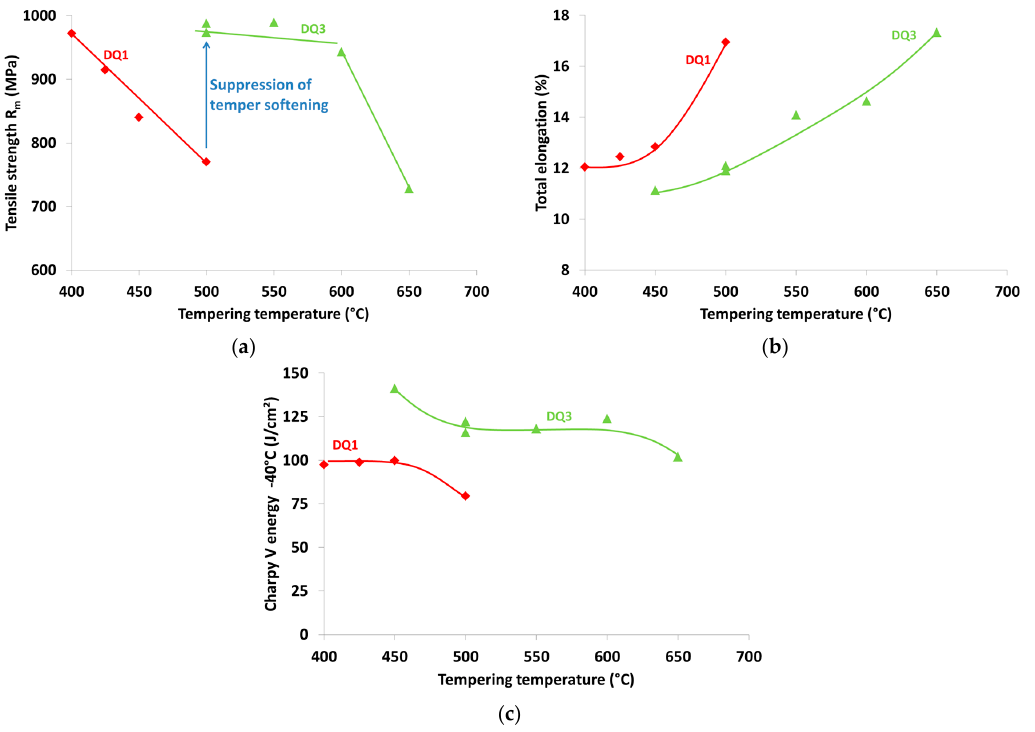
Figure 6. Comparison of mechanical properties of DQ1 and DQ3 steels for different temperatures ( a ) Tensile strength, ( b ) Total elongation (proportional test specimen), ( c ) Charpy V impact energy at − 40 °C.